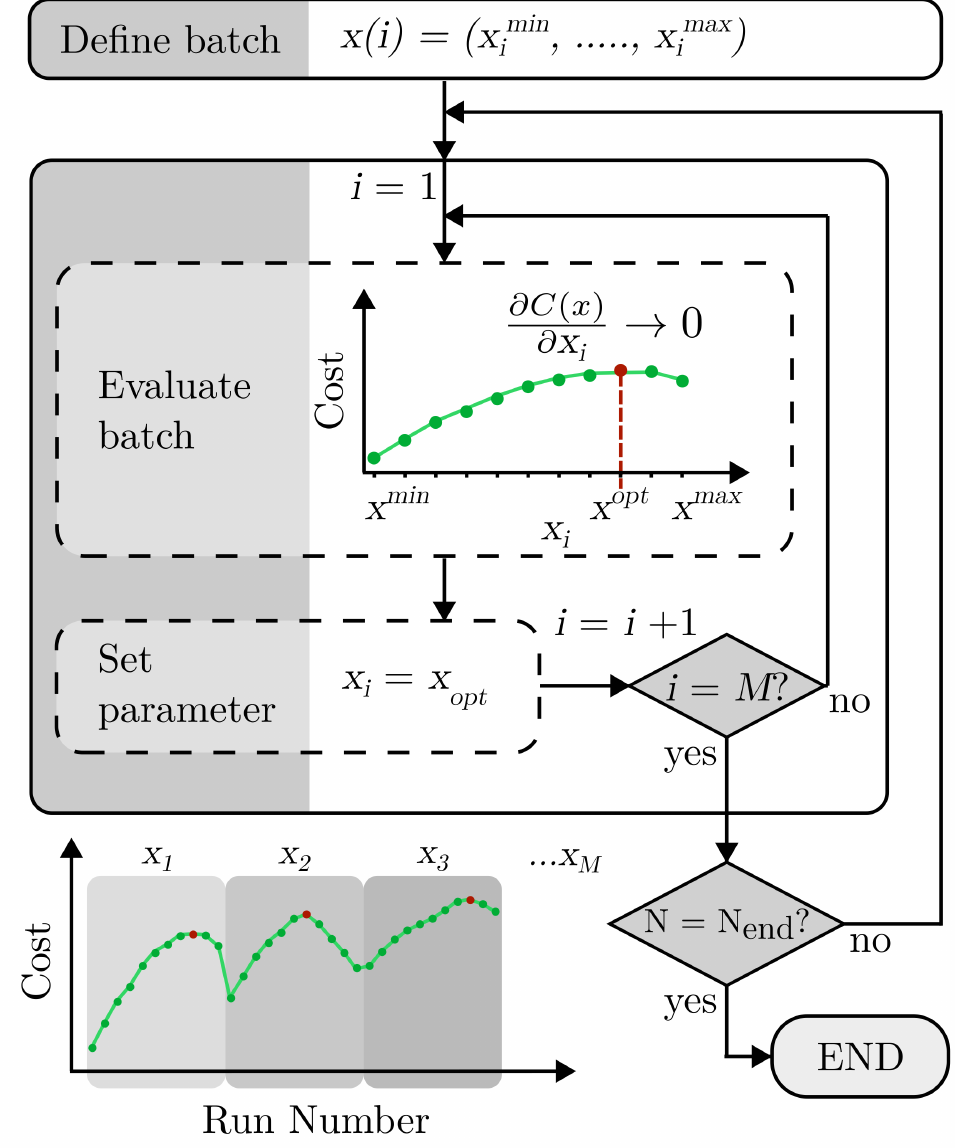
Figure 4. Gradient ascent algorithm process. x ( i ) , a vector value for a single parameter x i ranging from minimum x min to maximum x max as defined by parameter space range. i , the individual i i parameter selected. Initially, the first parameter is selected for the first batch i = 1. All other parameters are kept constant. The batch is evaluated based on cost, indicated in green, to find where the gradient tends to zero, ∂ C ( ρ ) 0 indicated in red. The corresponding parameter value x opt is ∂ x → then set for this parameter for the next batch, i = i + 1. This continues until all parameters are used as batches, for a total number of parameters M . The segmented graph shows this process as a function of the run number. This process in turn repeats until the end condition is met, where the number of sets of parameters tested N is equal to 250 ( N end